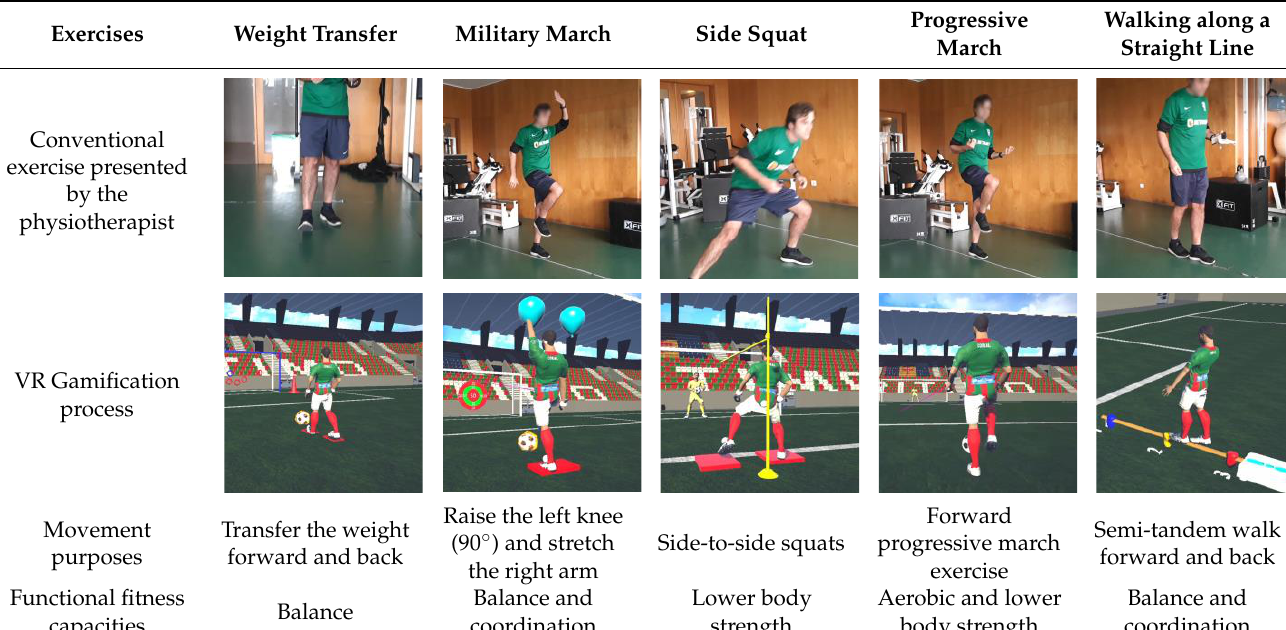
Table 1. Description of each VR game in terms of gamification, movement purpose, and the main functional fitness capacities involved.